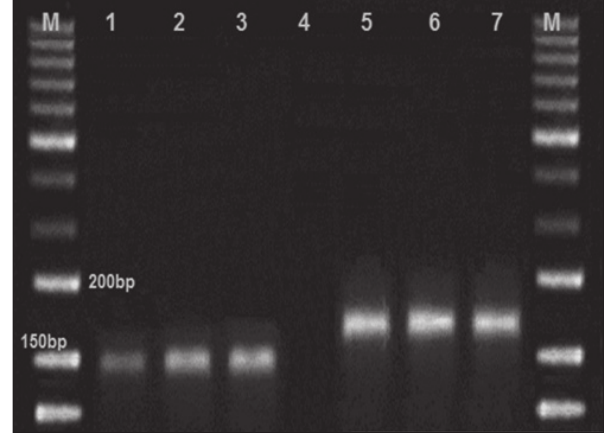
Figure-2: Results of polymerase chain reaction assay for differentiation of sheep pox virus (SPPV) and goat pox virus (GTPV). Lane (M): 50 bp ladder, Lane 1: SPPV positive control, Lane 2 and 3: SPPV positive samples, Lane 4: Control negative, Lane 5 and 6: GTPV positive samples, Lane 7: GTPV positive